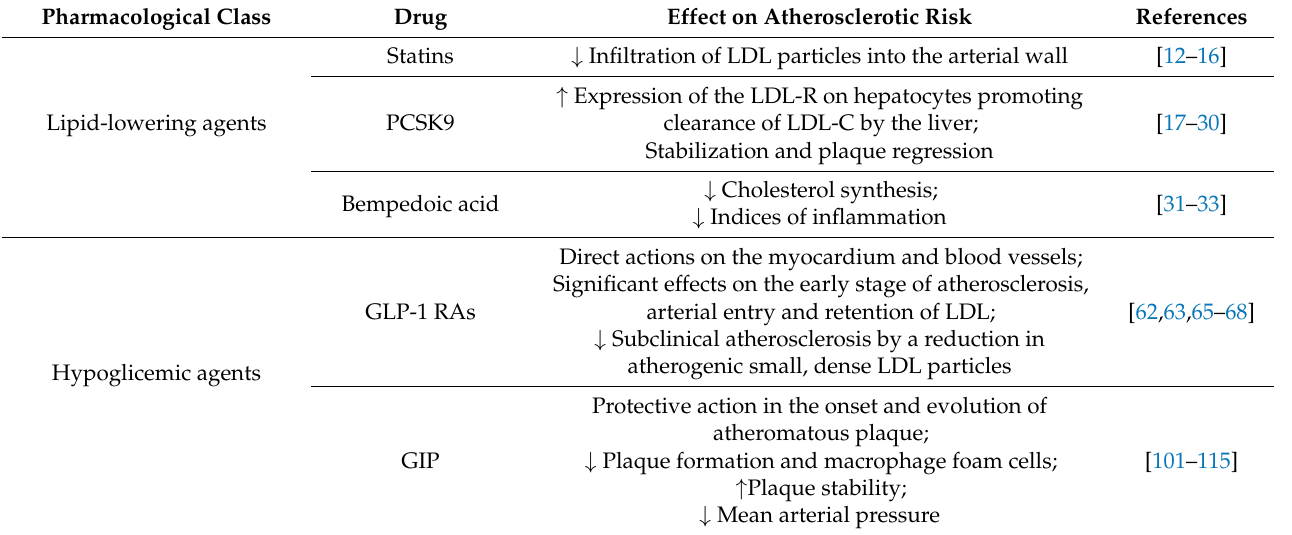
Table 1. Illustrative table with novel therapeutic approaches useful managing atherosclerotic risk. Pharmacological